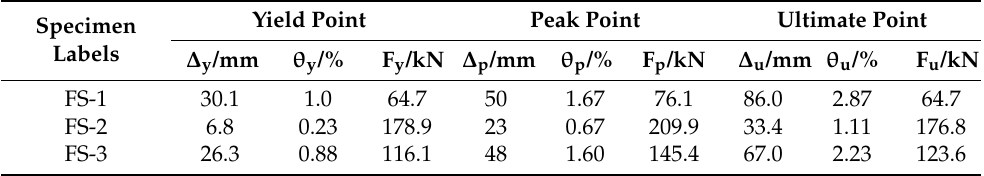
Table 2. Results of characteristic points of skeleton curves and ductility